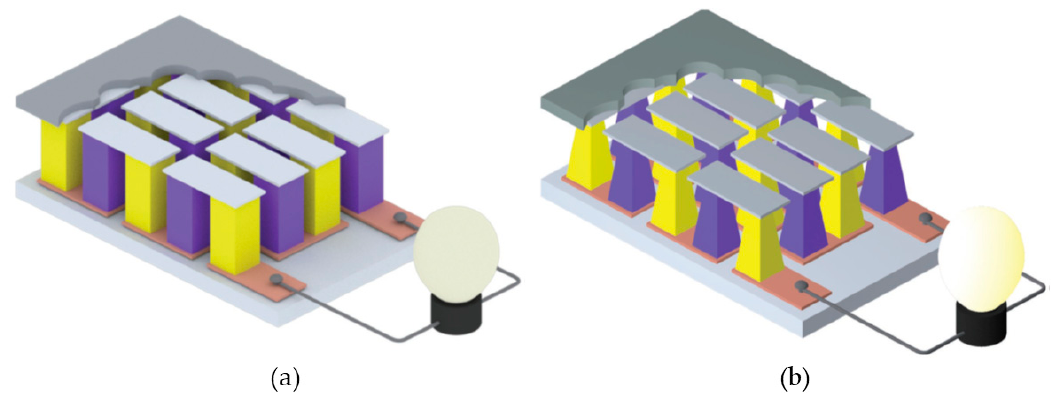
Figure 7. ( a ) Flat bulk TEG with n-type, p-type square legs; ( b ) flat bulk TEG with pyramidal legs [48].